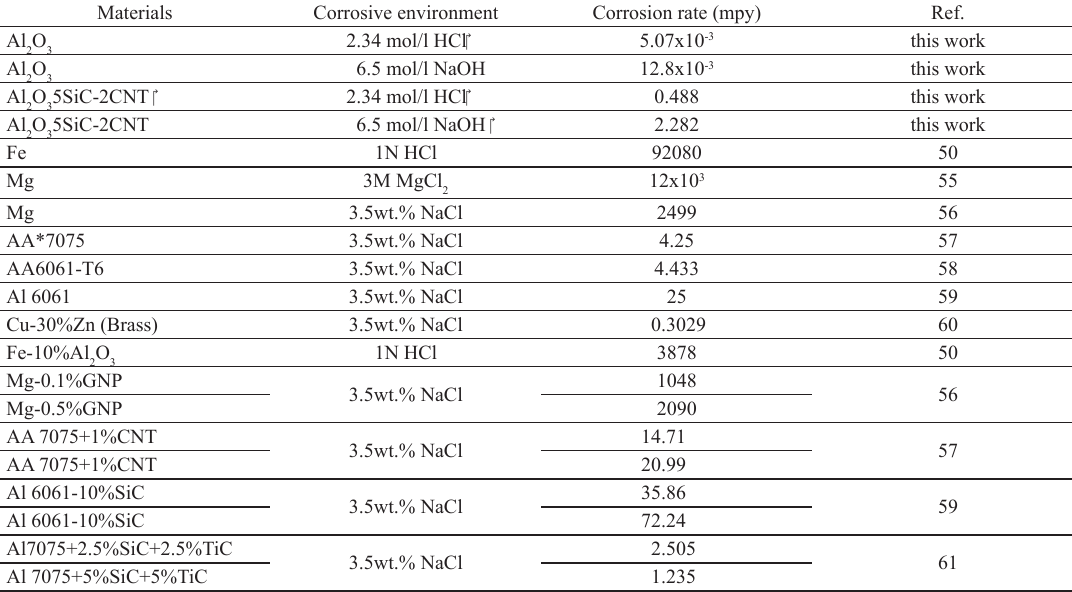
Table 2. Corrosion rates of different metals, alloys and metal-matrix nanocomposites